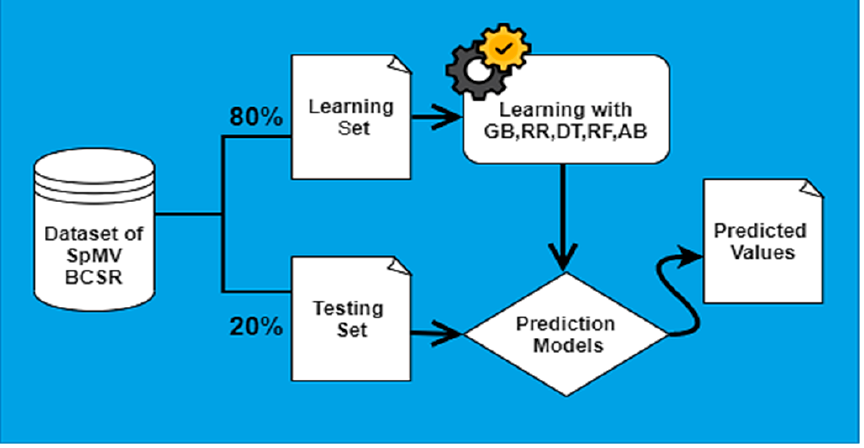
Figure 3. Training and testing